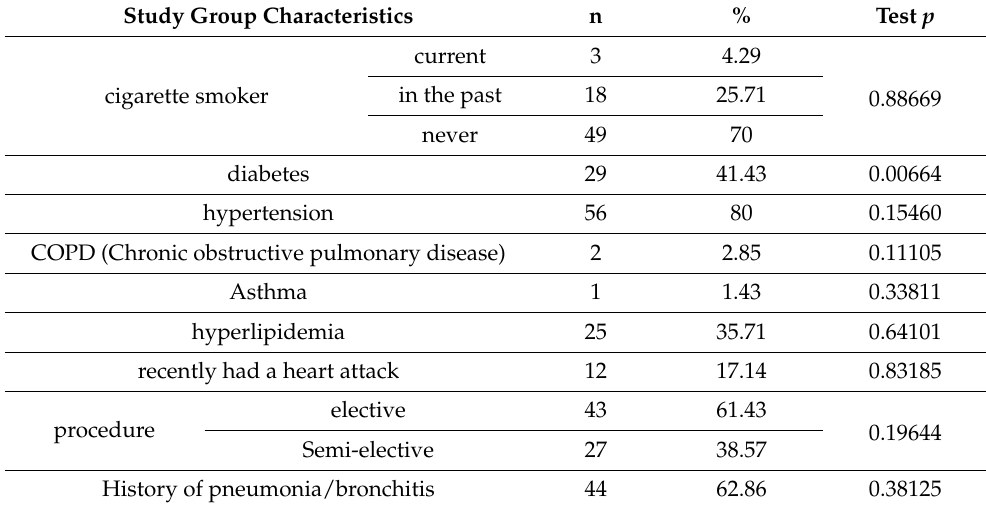
Table 1. General data/risk factors of the study group and assessment of its significance in correlation with the performed laboratory tests.